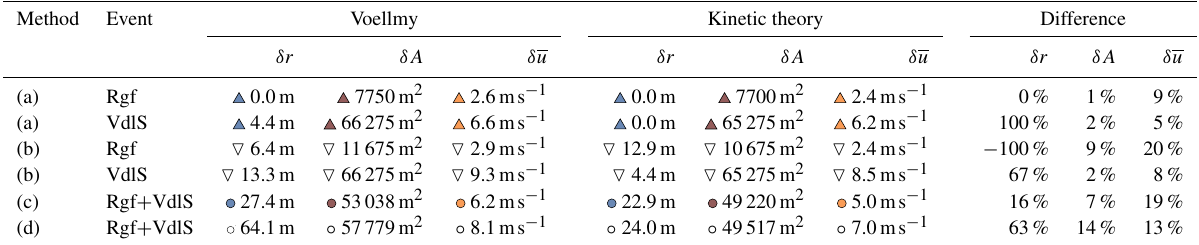
Figure 15. Areas in the parameter space with relatively small residuals (less than 10% on the normalized scale) for the runout length (blue), the affected area (red) and the velocity (yellow) for the different events and friction models. The triangle in the respective color marks the simulation with the smallest residual δX min . These residuals correspond to the evaluations of a single variable of a single event (type a). The white triangle marks the smallest combined residual, which corresponds to an evaluation of combined residuals of a single event (type b). Table 2. Obtained residuals for all possible result evaluations. Each symbol marks a set of parameters which can also be seen in the parameter space in Figs. 15 and